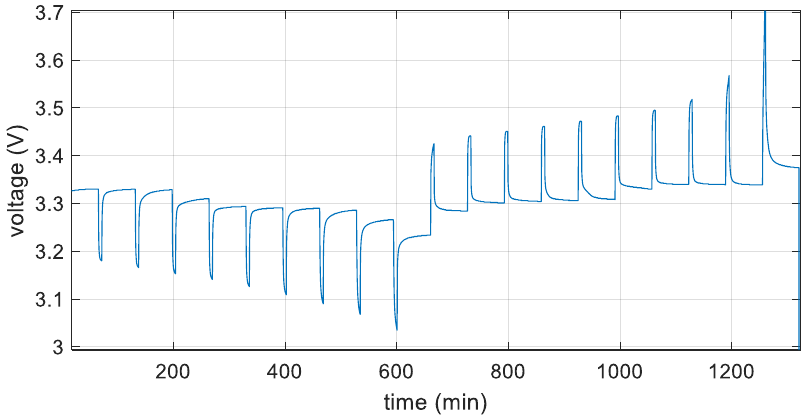
Figure 3. Example of voltage profile during MST.